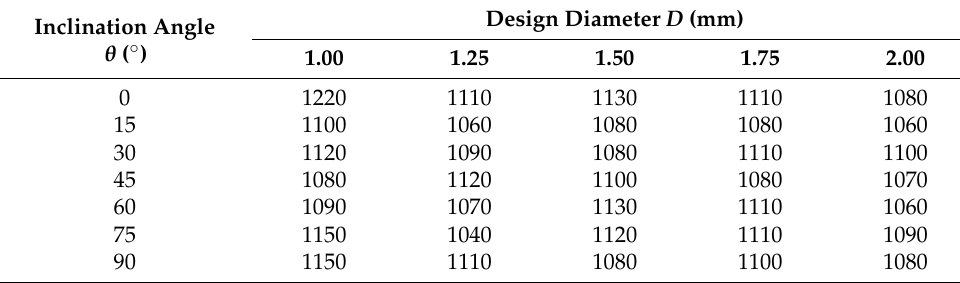
Figure 12. Schematic diagram of the tensile sample. Table 5. Tensile strength of RB sample (MPa).